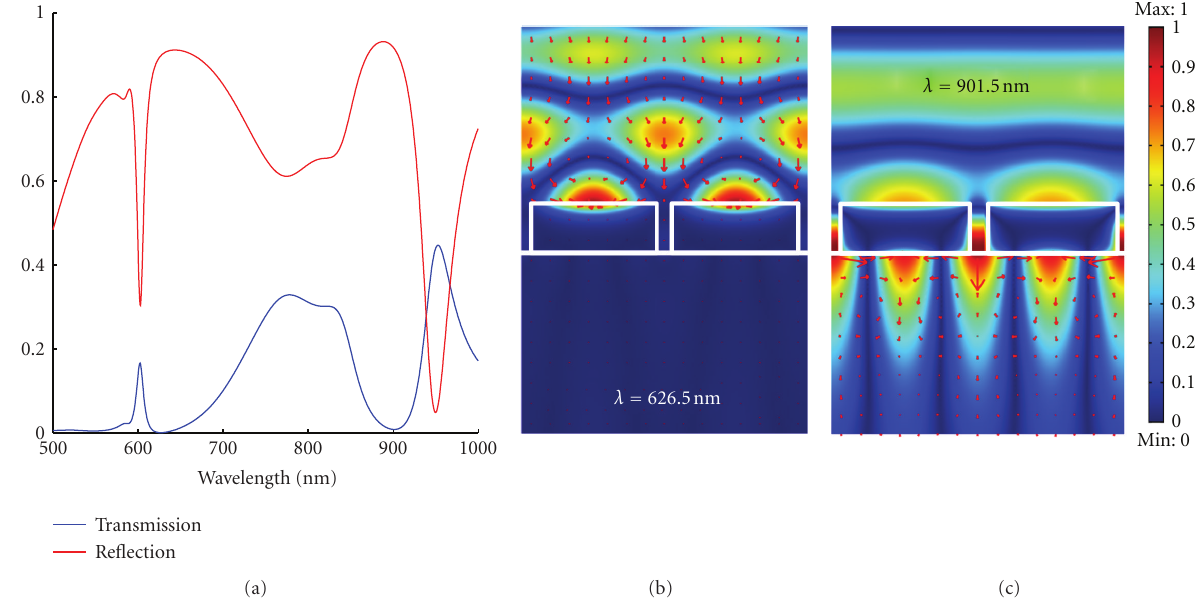
Figure 3: (a) Spectral response of an array of slits on the gold layer ( w = 200nm, p = 600 nm, l = 550nm) placed over a silica substrate ( n sub = 1.45). Profile of the absolute value of the magnetic field computed at (b) λ = 626.5 nm and (c) λ = 901.5 nm; red arrows express the direction of the Poynting